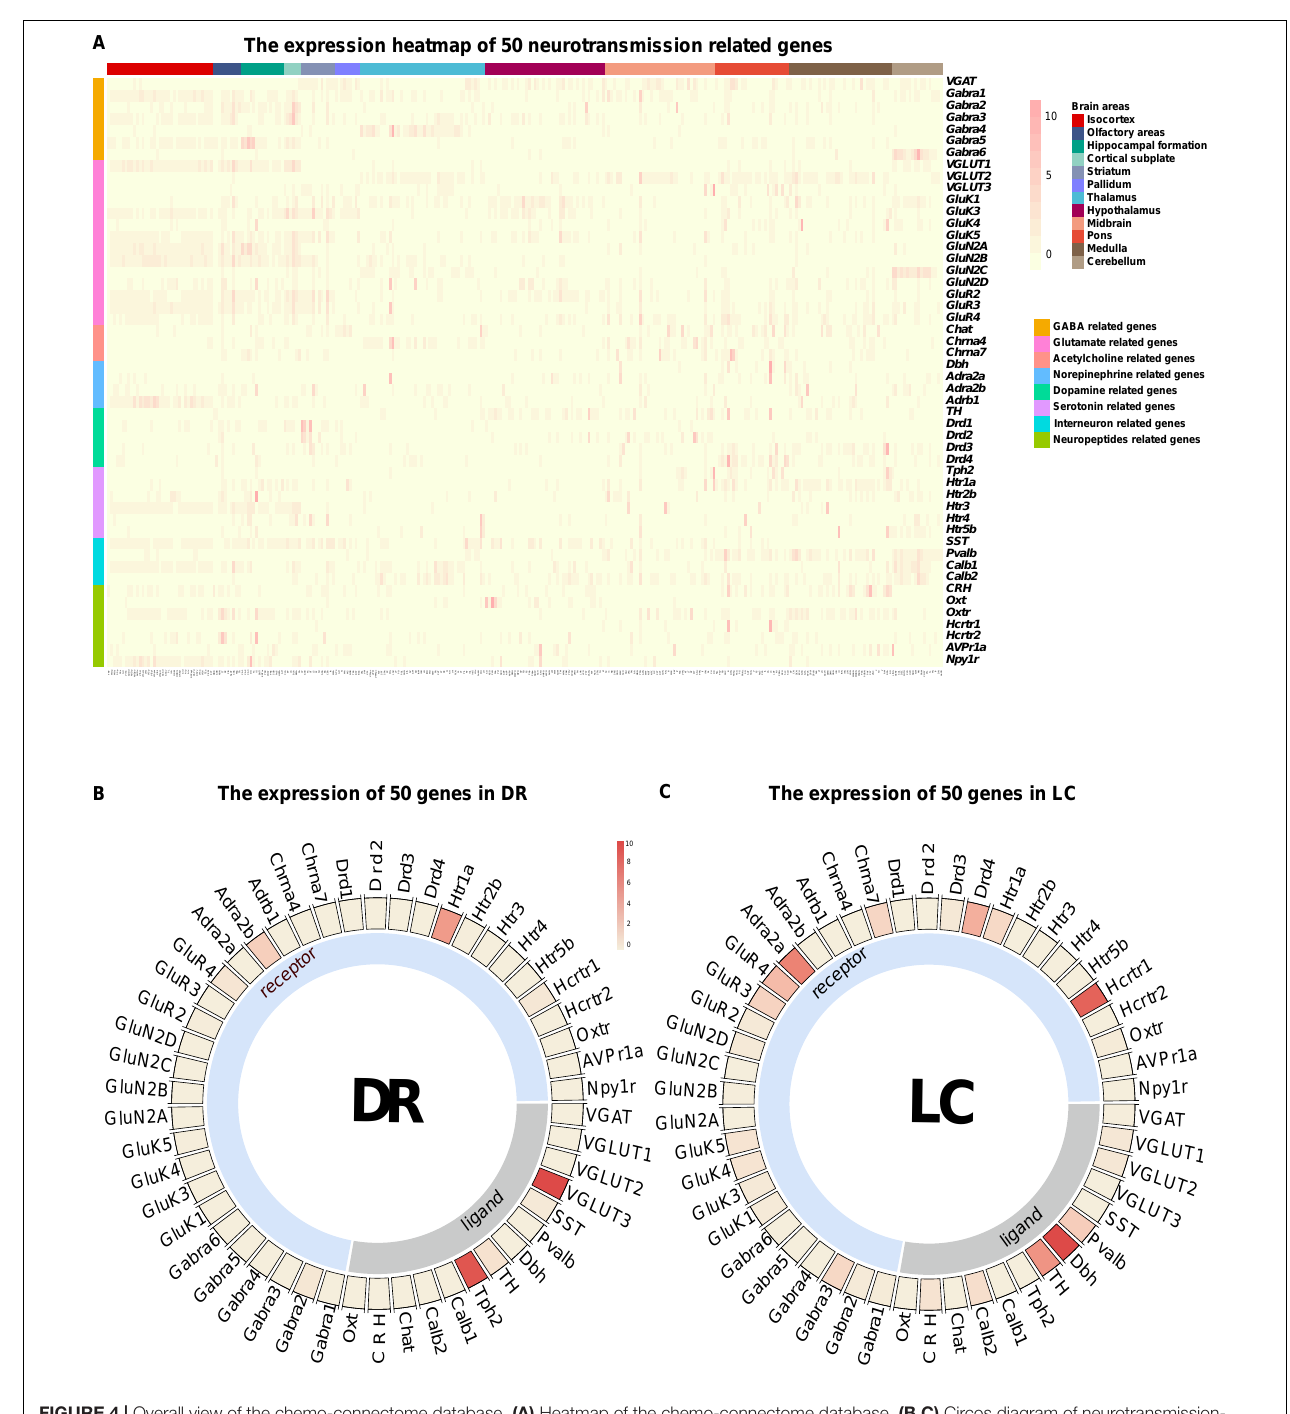
(Calabresi et al., 2014; Park et al., 2020). We found the upstream nuclei of them are almost the same ( Figures 3F,I